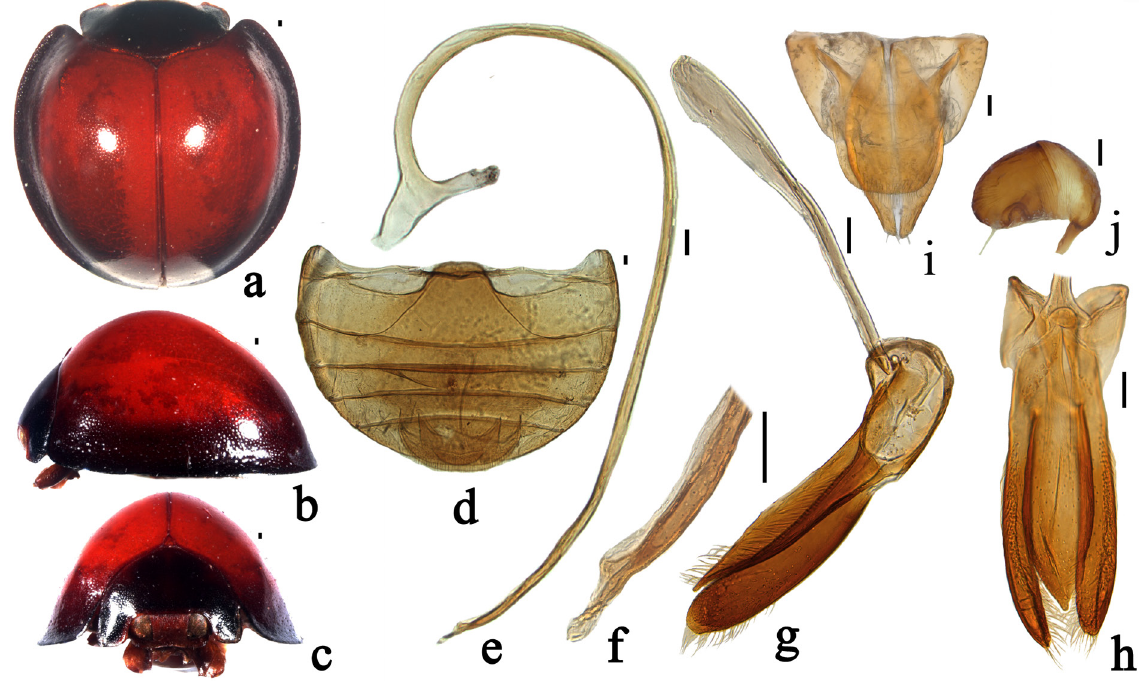
Fig. 8. Chilocorus rufitarsis Motschulsky, 1853. a . Dorsal view. b . Lateral view. c . Frontal view. d . Abdomen. e . Penis. f . Apex of penis. g . Tegmen, lateral view. h . Tegmen, ventral view. i–j . Female genitalia. i . Ovipositor. j . Spermatheca. Scale bars: 0.1